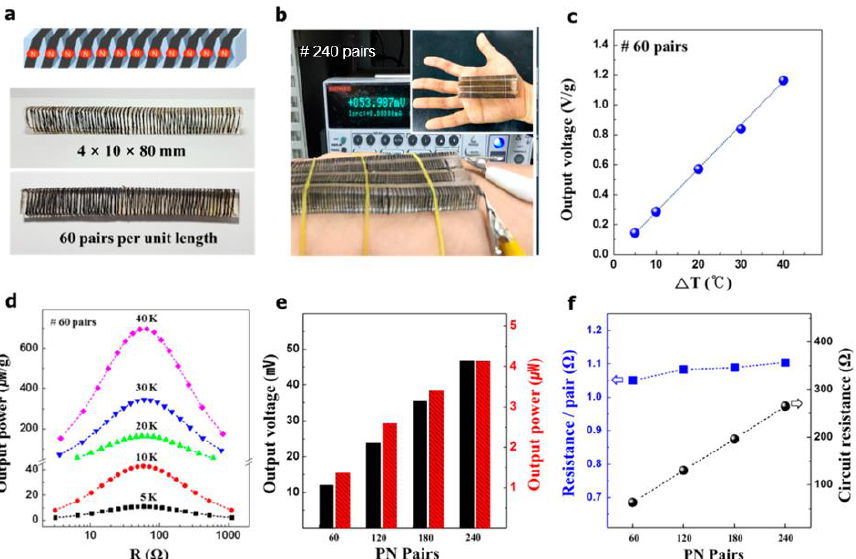
Figure 4. Performance of fiber-based thermoelectric generators. Reproduced with permission from Ref. [90]. Copyright © 2017, American Chemical Society. ( a ) Photograph of a thermoelectric generator with 60 P-N pairs. ( b ) The output voltage of the thermoelectric generator at room temperature. ( c ) The relationship between the output voltage density of the thermoelectric generator and the temperature difference. ( d ) The relationship between the output power density of the thermoelectric generator and the load resistance. ( e ) The output voltage and power of thermoelectric generators with different numbers of P-N pairs at ΔT = 5 °C. ( f ) The average resistance of each P-N pair and the circuit resistance of the thermoelectric generator at ΔT = 5 °C.